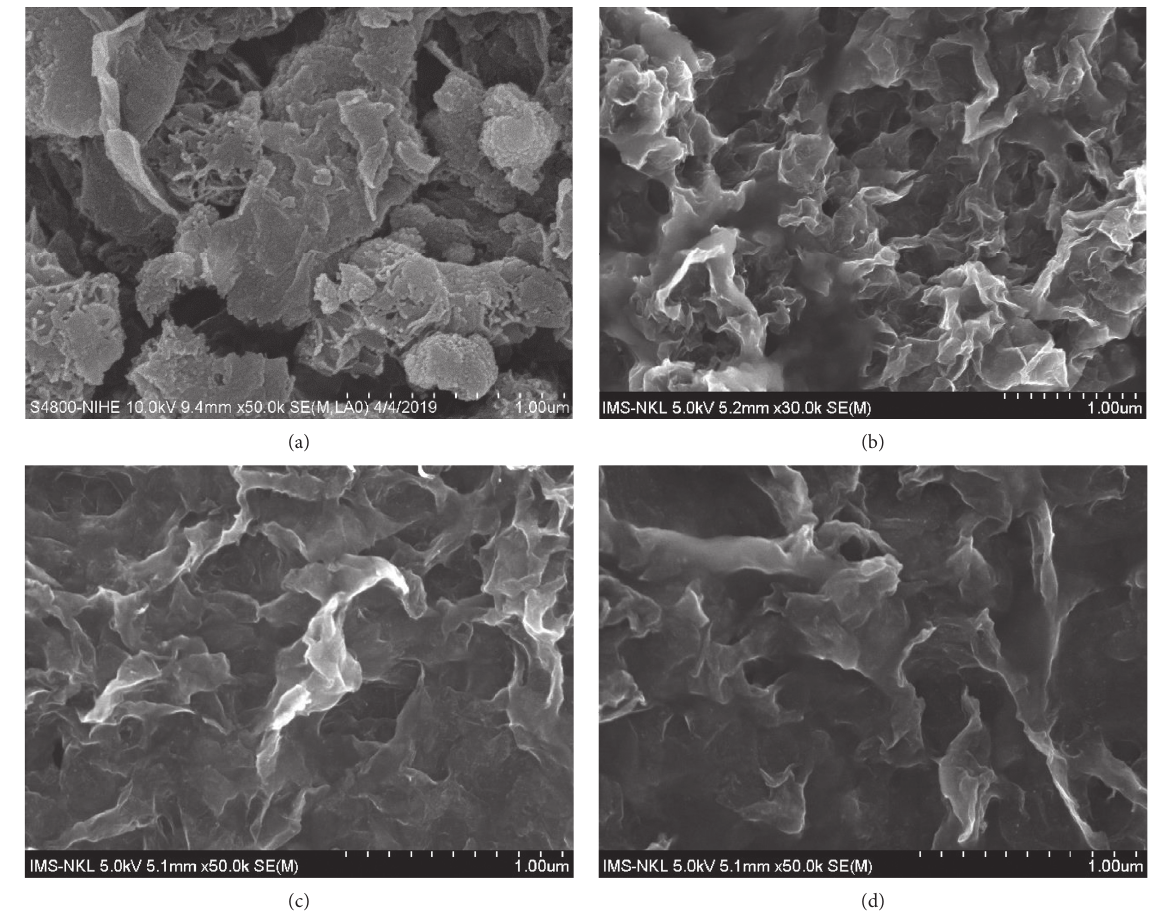
Figure 13: SEM images of electrode-coated CI-WATER (a), CI-NBA (1/1) (b), CI-IPA (1/1) (c), and CI-EtOH (1/1) (d) inks at a magnification of 1 :50.000. Table 2: CV data of the catalyst inks in ethanol